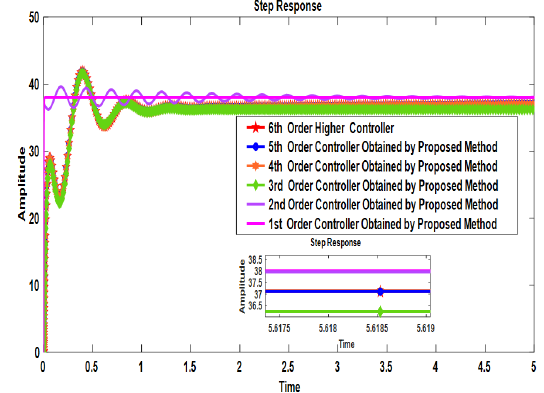
Figure 4: Time response of original and different reduced order controllers by proposed method without bicyrobo